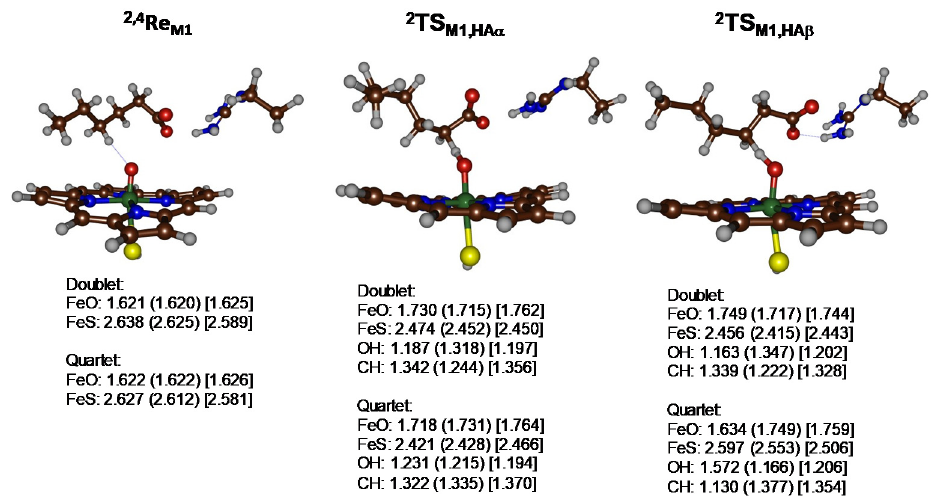
Figure 12. Extracts of the QM region of the QM / MM optimized geometries of the reactant and transition states for C α -H and C β -H hydrogen atom abstraction for the double mutant Asn242Arg / Arg245Asn. Bond lengths are in angstroms for Sn 800 (Sn 850 ) and [Sn 900 ].